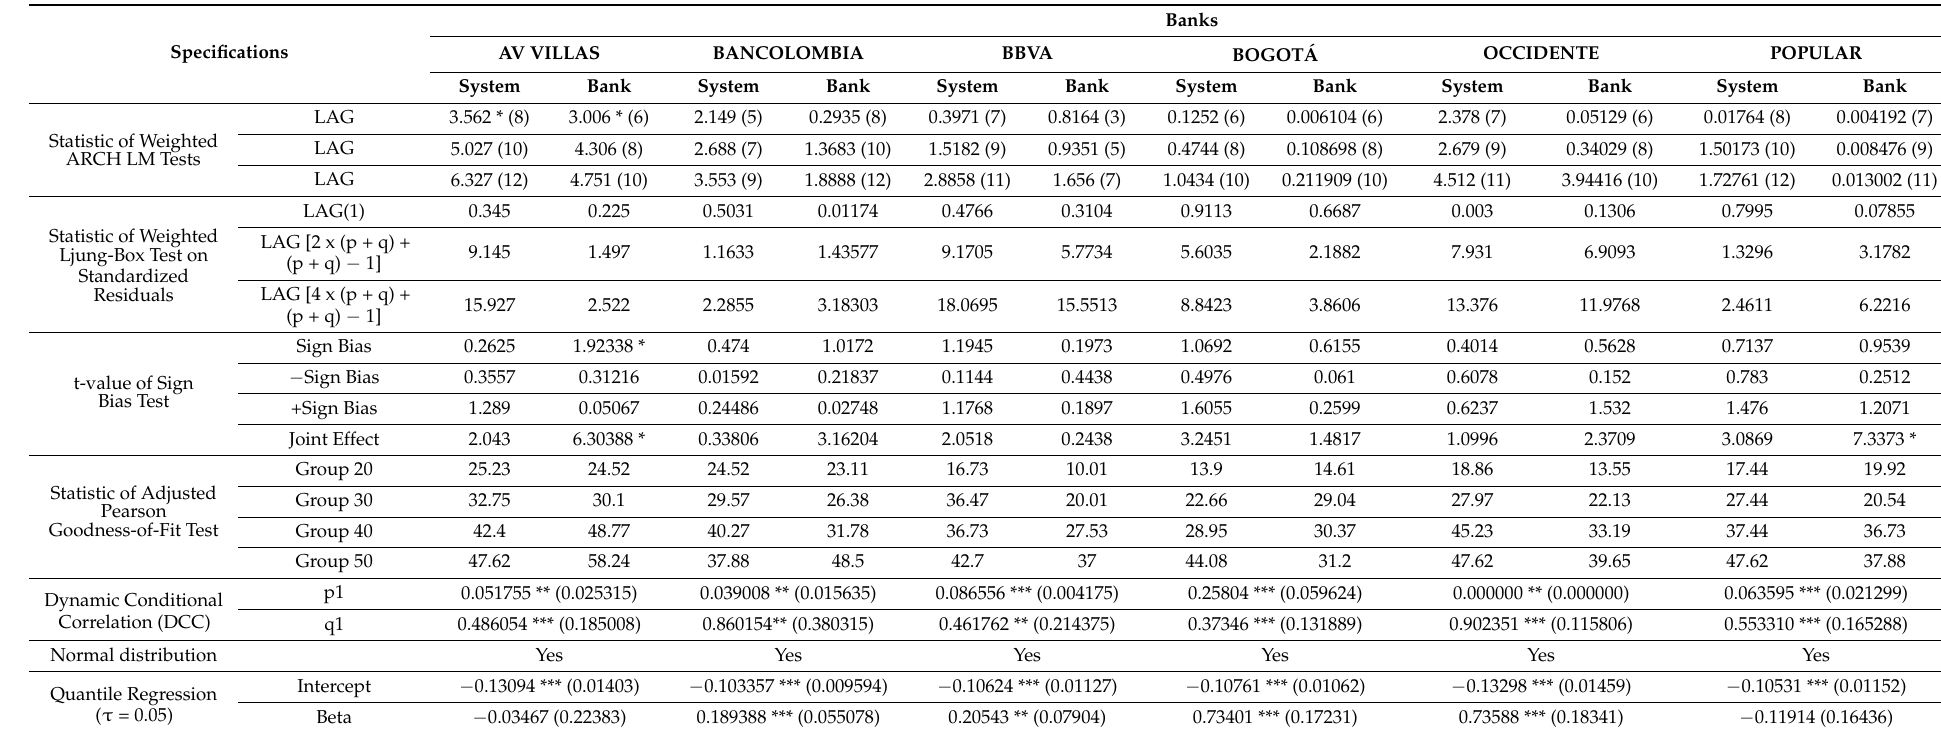
Table 3. Estimated results for the data